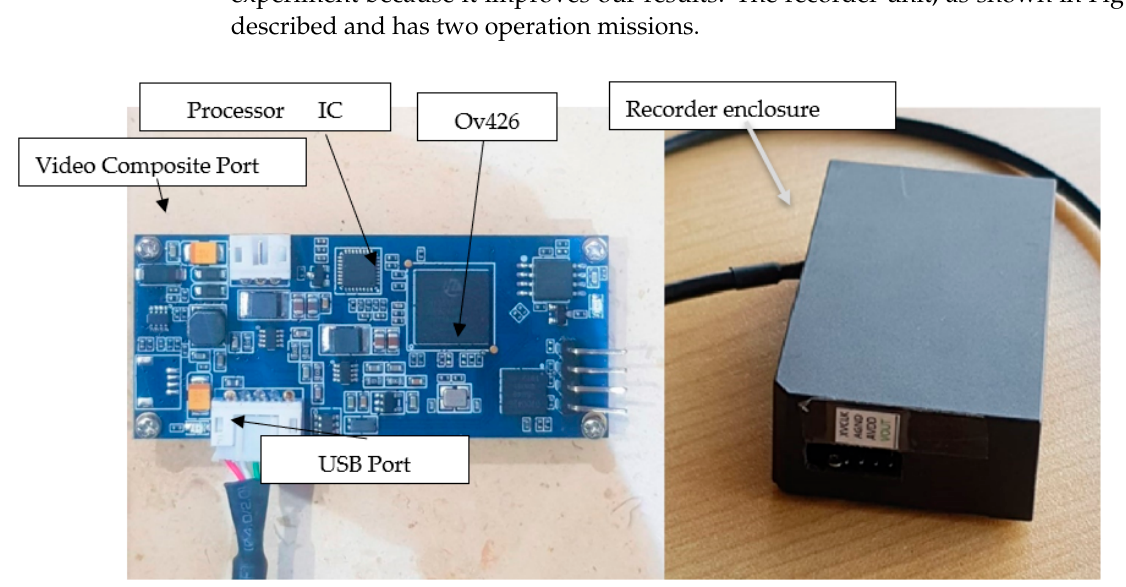
Figure 7. Capsule cover after 3D printing .